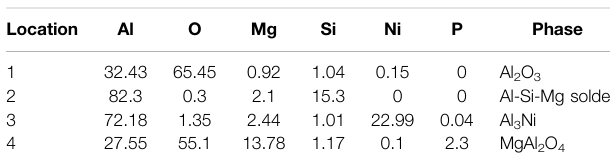
TABLE 4 | EDS scan results of each point in Figure 10 (at%). Location